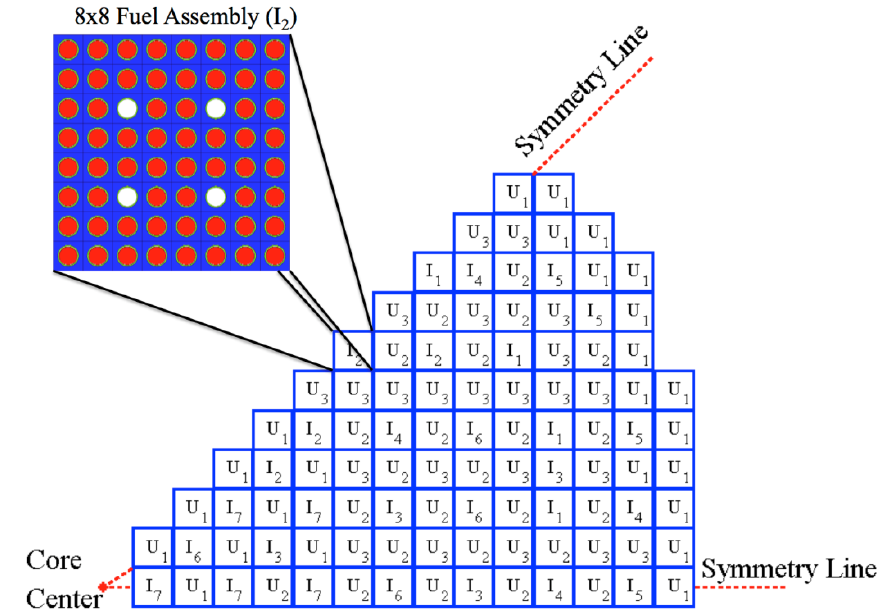
Figure 2. Fuel assembly configuration. ( left ) Schematic of an 8 × 8 fuel assembly with 60 fuel pins and 4 guide tubes; ( right ) The assembly layout of the reactor was designed and I represent the x th campaigns of uranium fuel and with 8-fold symmetry. Here the U x x inert matrix fuel assemblies. A center assembly is left empty (moderator region). Each fuel assembly is 8 × 8 with 4 control rod guide tubes and 60 fuel